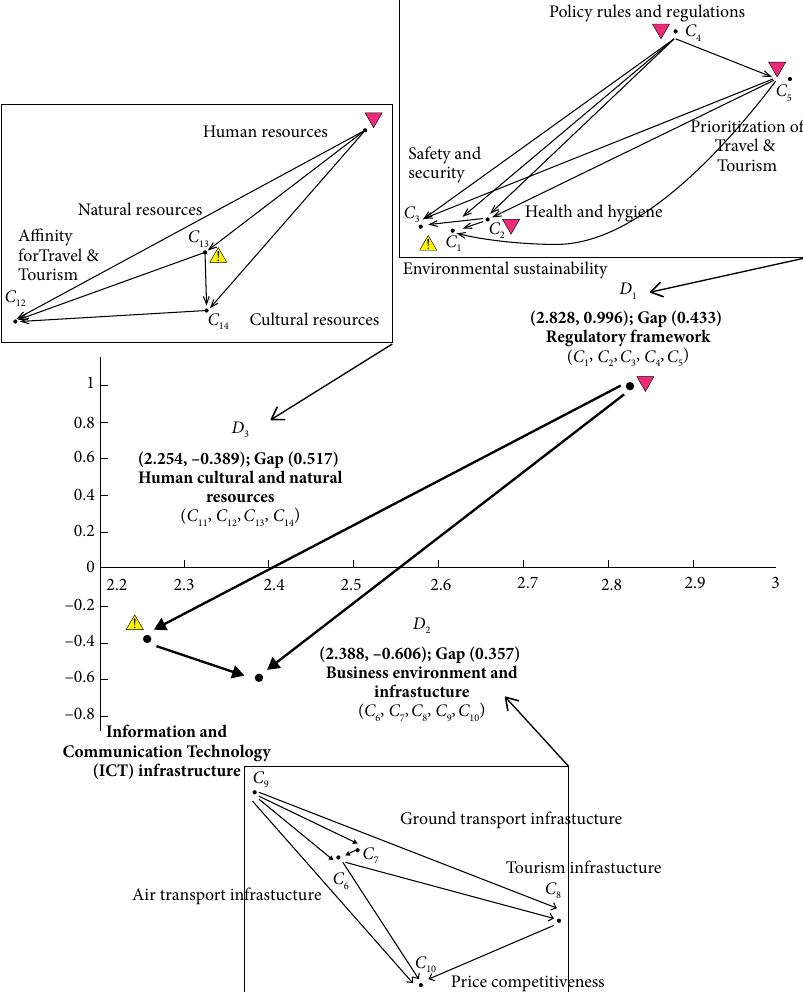
Fig. 3. The influential network relations map of each dimension and criteria